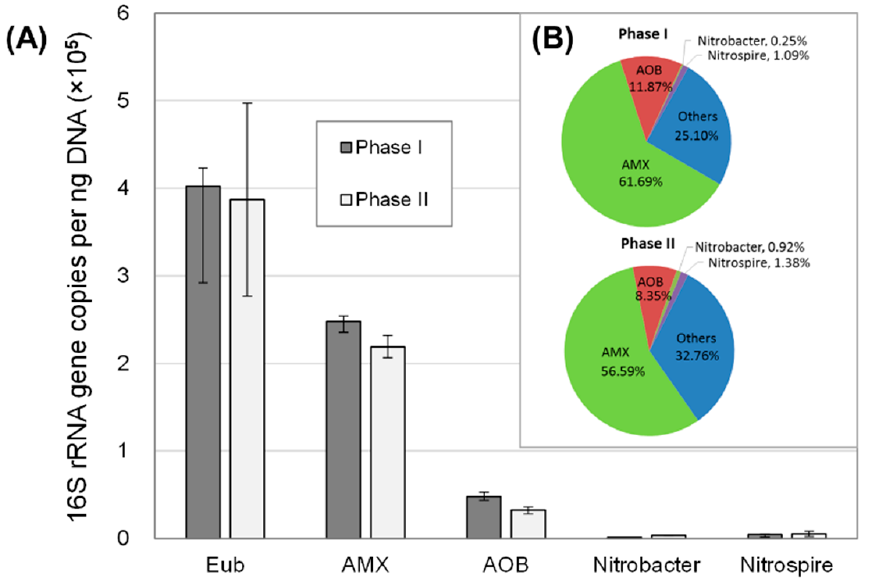
Figure 3. 16S rRNA gene copies ( A ) and relative abundance ( B ) of total bacteria (Eub), AMX, AOB, Nitrobacter and Nitrospira in Phase I (day 64) and Phase II (day 118) using real-time quantitative PCR. Error bars indicate the standard deviation of three reactions.